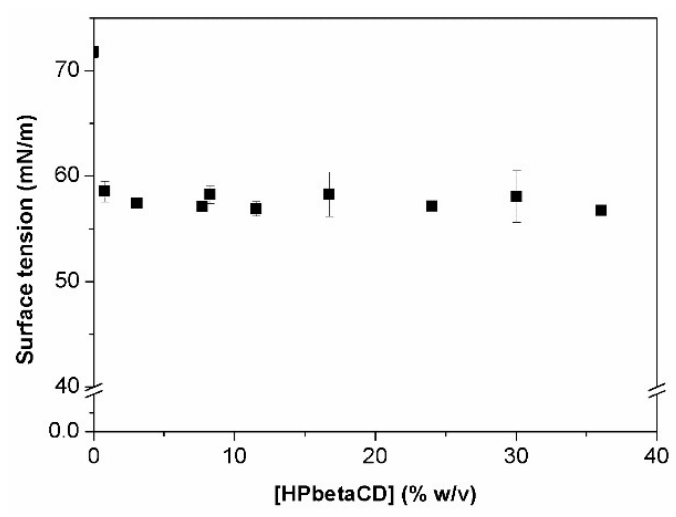
Figure 4. Surface tension variation with concentration of HPβCD aqueous solutions at 25 °C.